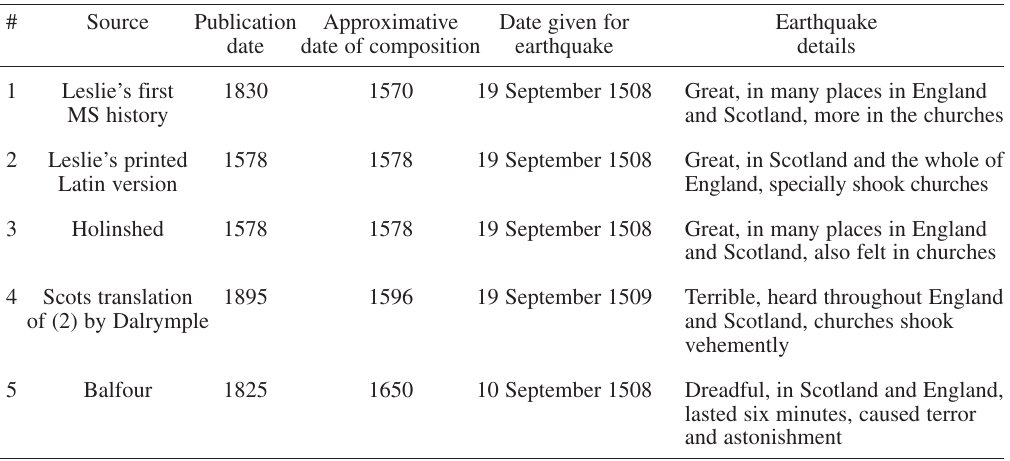
Table II. Summary of sources for the 1508